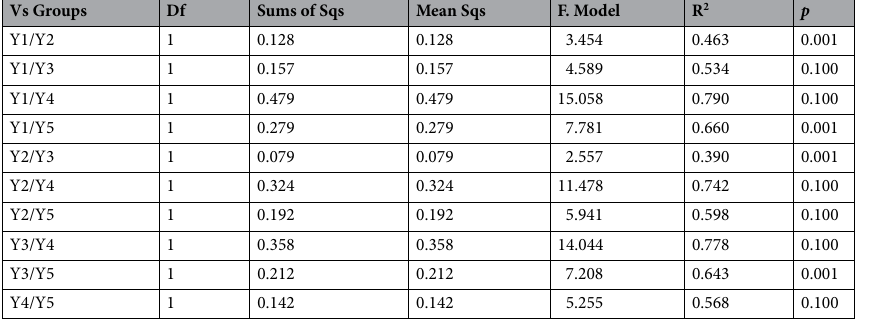
Table 4. Adonis analysis between groups. Df: Degree of freedom; Sums of Sqs: Total variance; Mean Sqs: Mean square, Sums of Sqs/Df; F. Model: F inspection value ; R 2 : The explanation degree of the differences among different groups of samples, i.e. the ratio of grouping variance to total variance, the larger R 2 means the higher the explanation of the difference; p : p < 0.05 indicates that the reliability of the test is high.